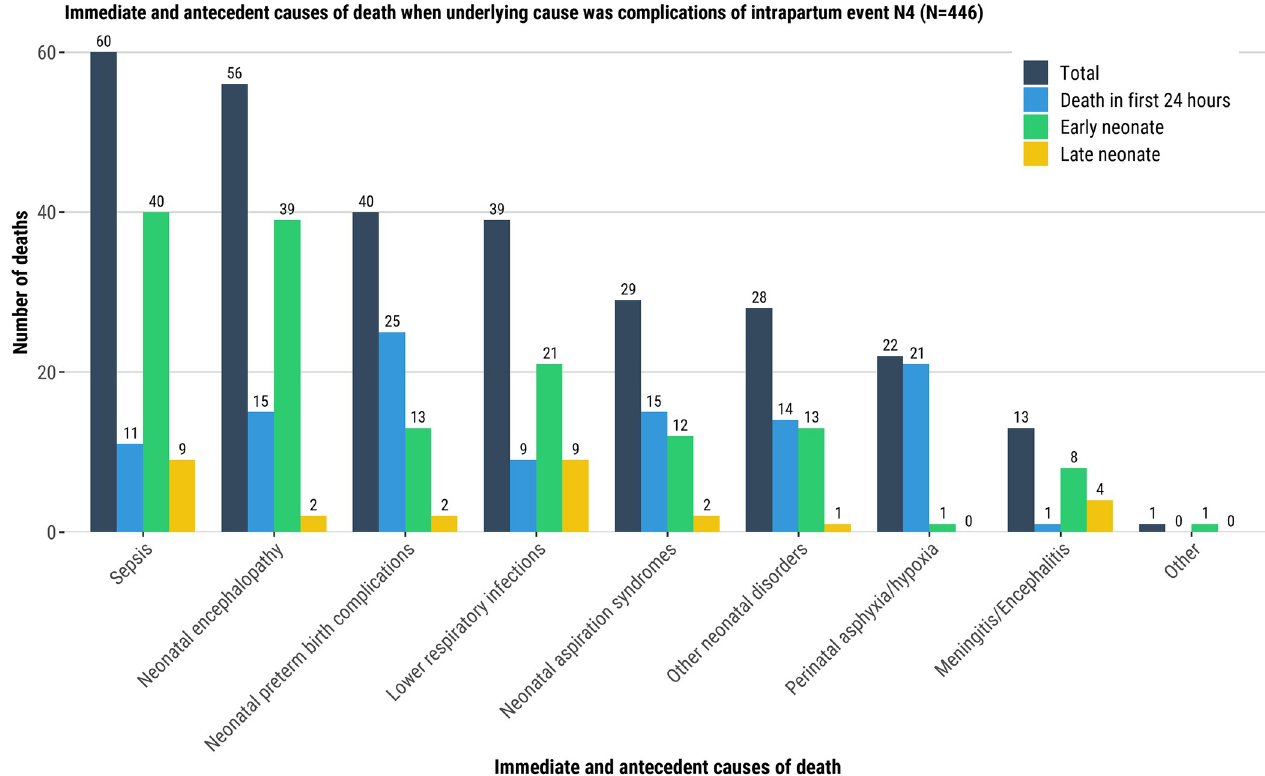
Fig 4. Immediate and antecedent causes of death when underlying cause was complications of intrapartum event N4 (N = 446). Immediate and antecedent causes of death.